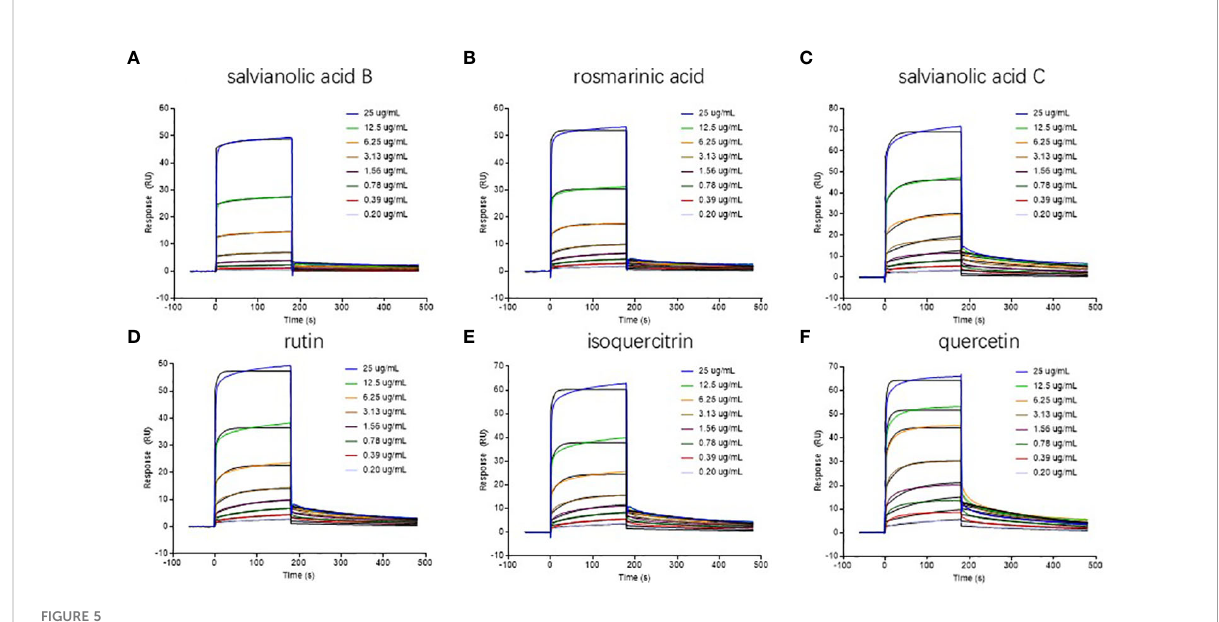
FIGURE 5 Real-time sensorgrams of kinetic analysis of the interactions between drugs and ER b at 25 °C (A) salvianolic acid B; (B) rosmarinic acid; (C) salvianolic acid C; (D) rutin; (E) isoquercitrin; (F) quercetin.